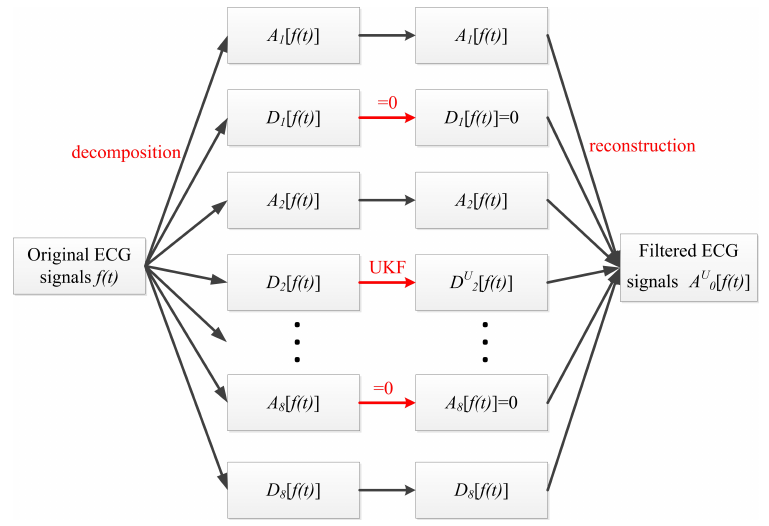
Figure 5. Basic flow chart of WT-UKF